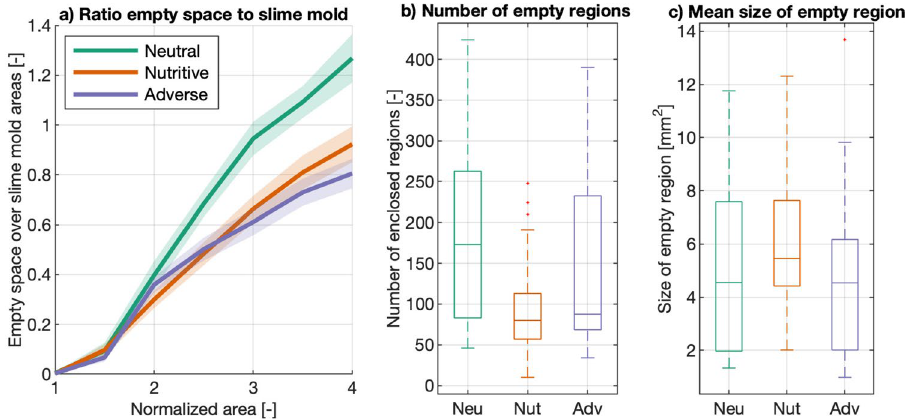
Figure 5. Empty regions inside slime mold cell. ( a ) Ratio between empty space inside slime mold cell and slime mold area as a function of normalized slime mold cell area (An). The solid lines and shaded areas correspond to the means and confidence intervals among replicates, respectively. ( b ) Boxplot graph of the number of enclosed empty regions inside the slime mold cell at An = 4. ( c ) Boxplot graph of the mean size of the empty region at An = 4, computed as the total empty area divided by the number of enclosed regions. Box plots show median (horizontal line), interquartile range (box), distance from upper and lower quartiles times 1.5 interquartile range (whiskers), and outliers ( > 1.5 x upper or lower quartile).